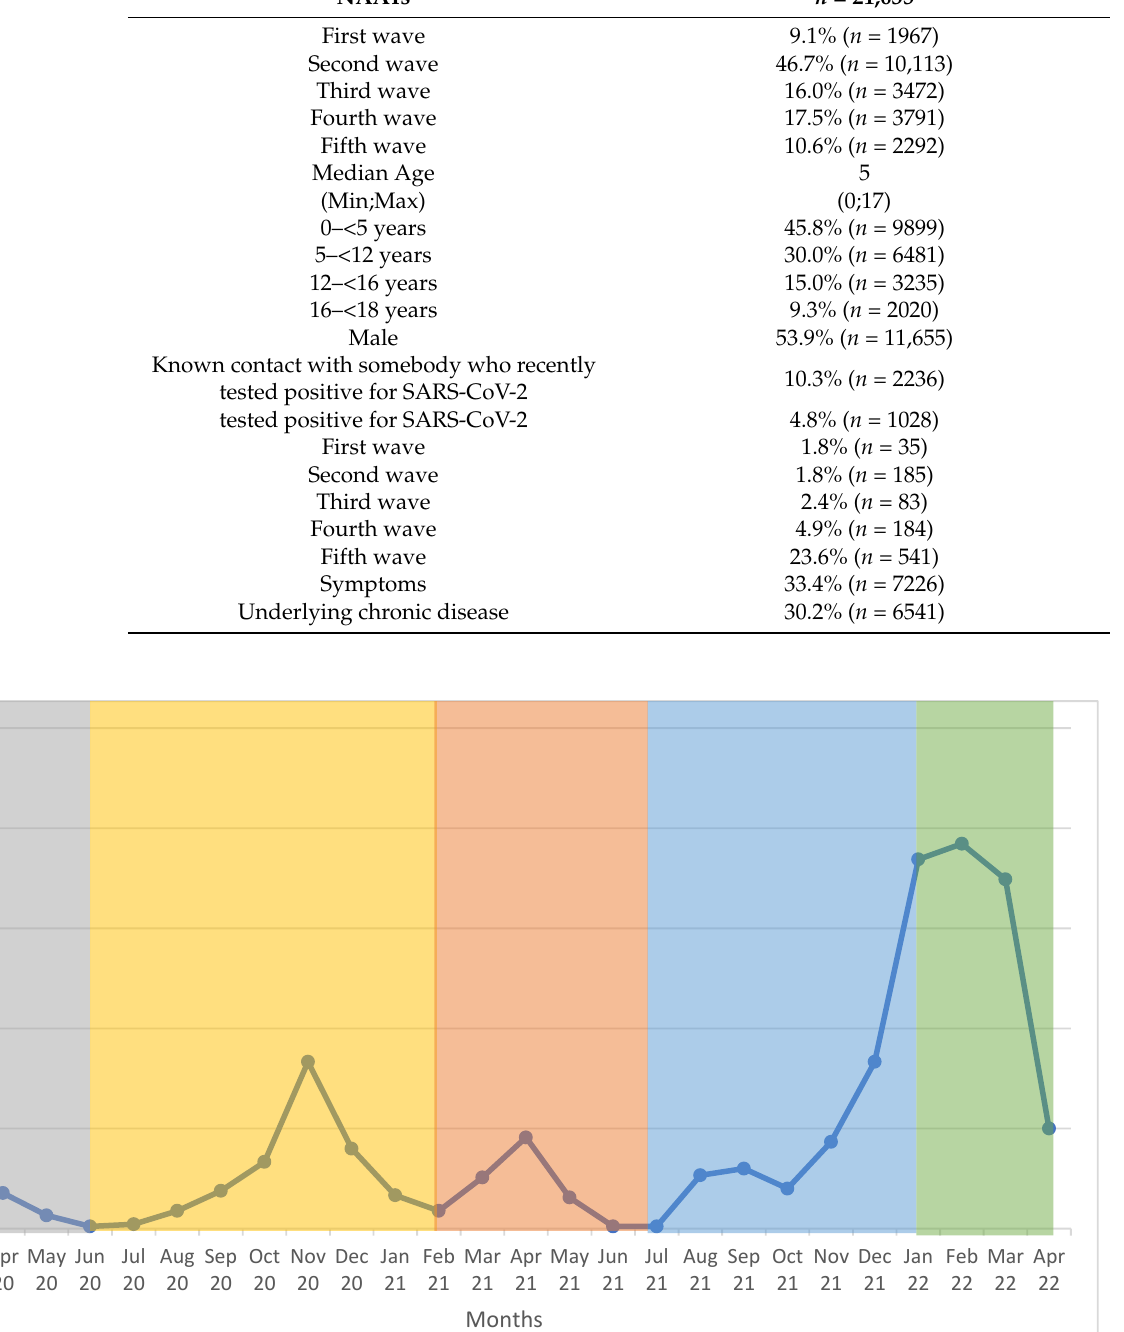
Table 2. Demographic data from n = 21,635 SARS-CoV-2 nucleic acid amplification tests (NAATs) on children and adolescents between the age of 0 and 18 years .